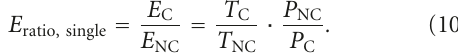
Figure 9: E ratio, system plotted against DR Cell for di ff erent sizes of D tot